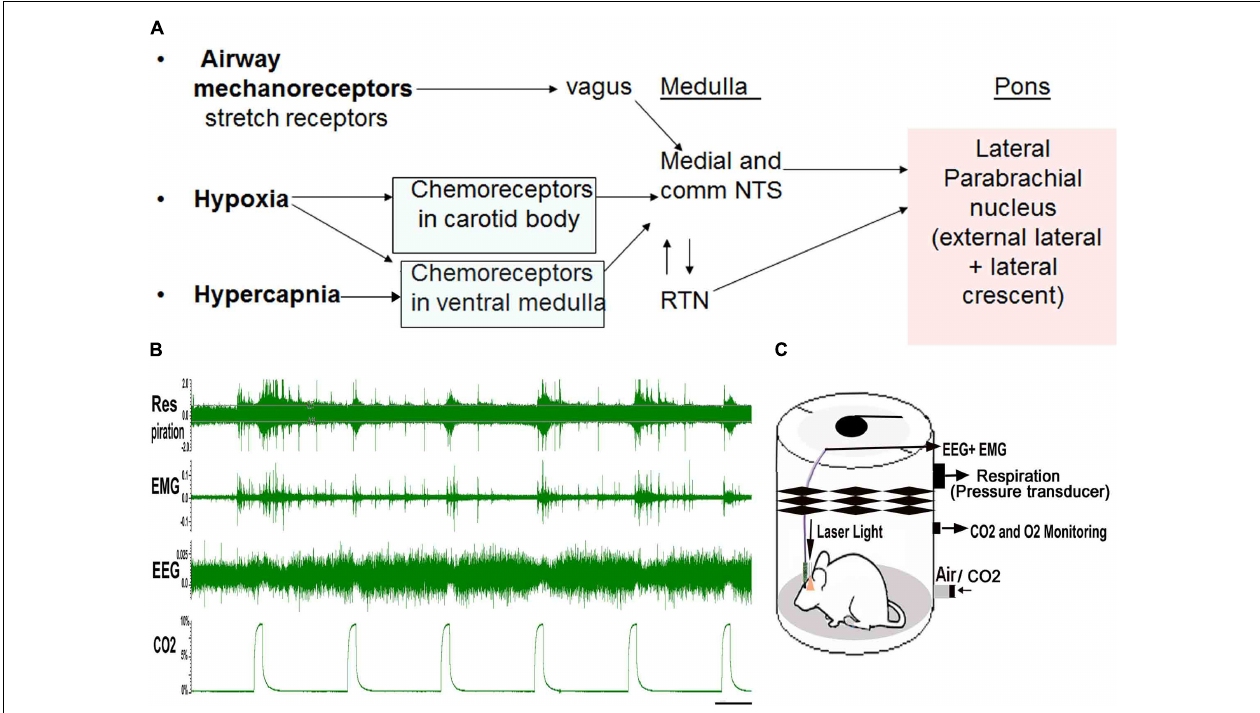
FIGURE 1 | (A) , Three main stimuli related to apnea converge on the parabrachial area: Increased CO 2 (Hypercapnia), Hypoxia and negative air-way pressure cause activation of both central and peripheral chemoreceptors whose signals are integrated in the nucleus of the solitary tract (NTS) and retrotrapezoid nucleus (RTN). The NTS and RTN activate neurons in the lateral parabrachial nucleus, major node in the brain stem that relay visceral sensory information to the forebrain areas. Mouse model of apnea: (B) , shows the “repetitive CO2 arousal (RCA) protocol” where a mouse is recorded in the plethysmograph chamber for the EEG, EMG and breathing, while exposed to repeated bouts of CO2 (hypercapnia). Mice undergo spontaneous periods of sleep and wake, however, only trials where the mouse is in NREM sleep for at least 30 s prior to onset of the CO2 are used to examine arousal. During these trials, the arousals are judged by EEG arousal (loss of delta waves and appearance of low voltage fast EEG), which is usually accompanied by EMG activation. Scale = 45 s (C) , is a schematic of the plethysmography chamber used to model apnea in mice, while they are exposed to CO2 and recorded for EEG/EMG and breathing responses, with and without laser light that is transmitted through the pre-implanted optical glass fibers. [Adapted and modified from Kaur et al. (2013)]. Kaur et al. (2013), is published under Creative Commons Attribution-Non-commercial-Share License, and therefore no permission is required reproducing this modified version.